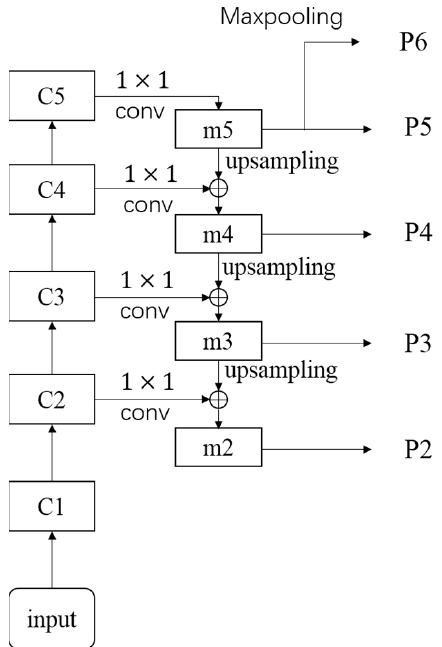
Figure 3. Feature pyramid networks (FPN) structure.